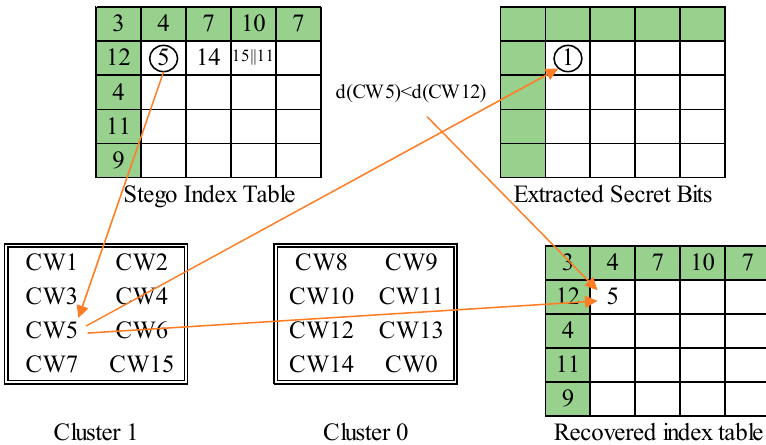
Figure 15. Extraction example 1: matched case.